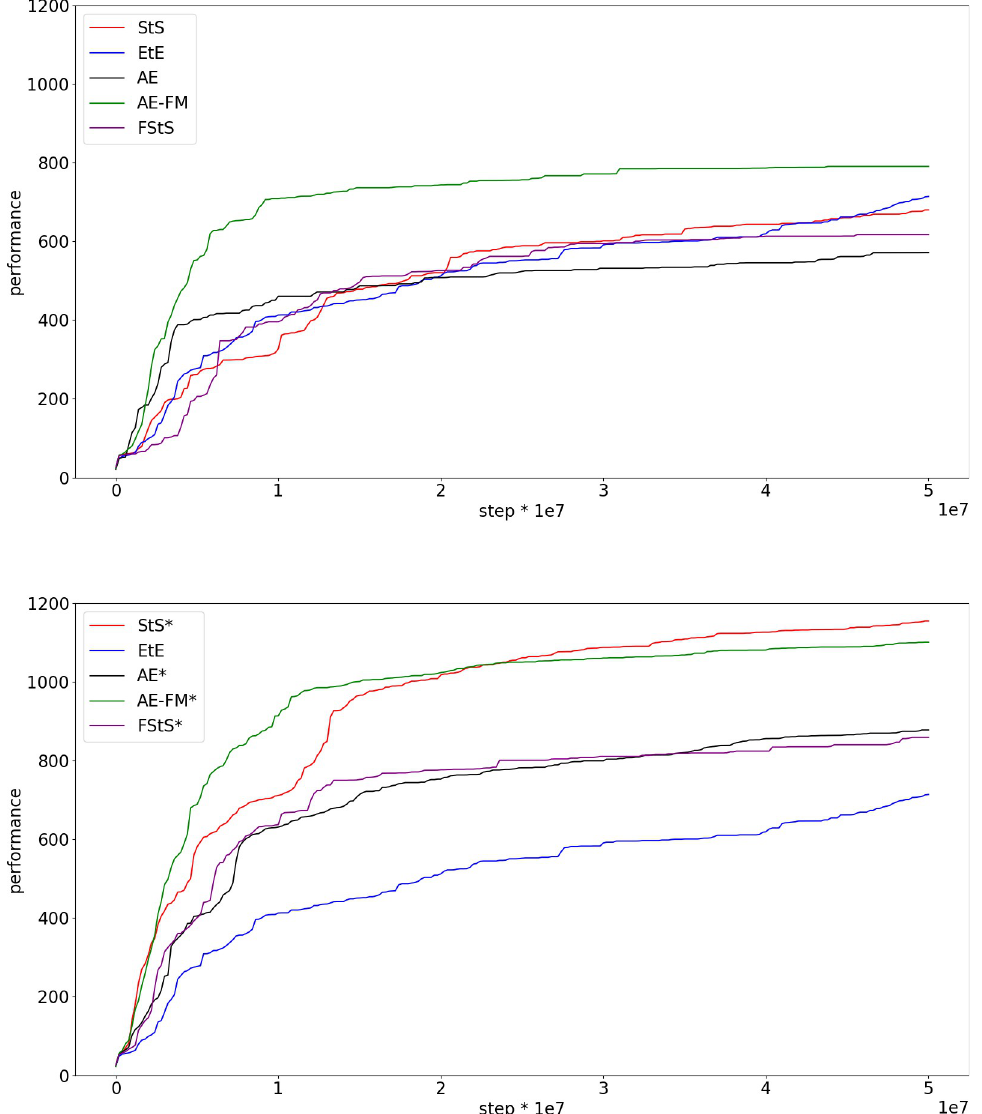
Fig 3. Performance during the training process in the case of the Walker2DBullet problem. Performance refer to the average fitness of the best agent achieved so far. Data computed by post-evaluating the best individual of each generation for 3 episodes. Each curve shows the average result of 10 replications. The top and the bottom figures show the results obtained in the experiments performed in the pre-training and continuous training modalities, respectively.